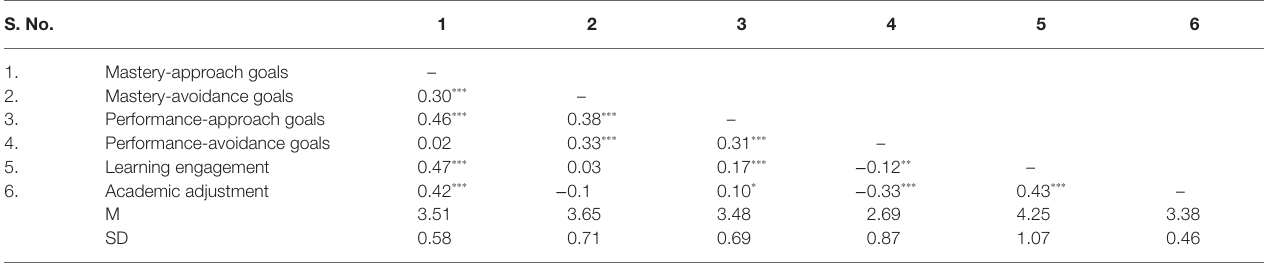
TABLE 1 | Means, standard deviations, and correlations ( n = 578) of the core variables. S. No.